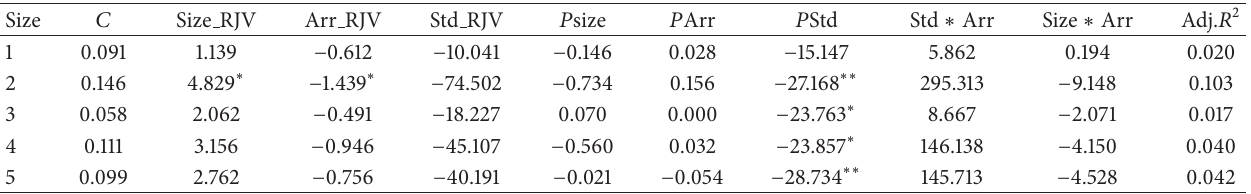
Table 12: Forecasting one-month-ahead individual-based portfolio returns using realized jump volatility-based factor model with cross-term of its jump components.